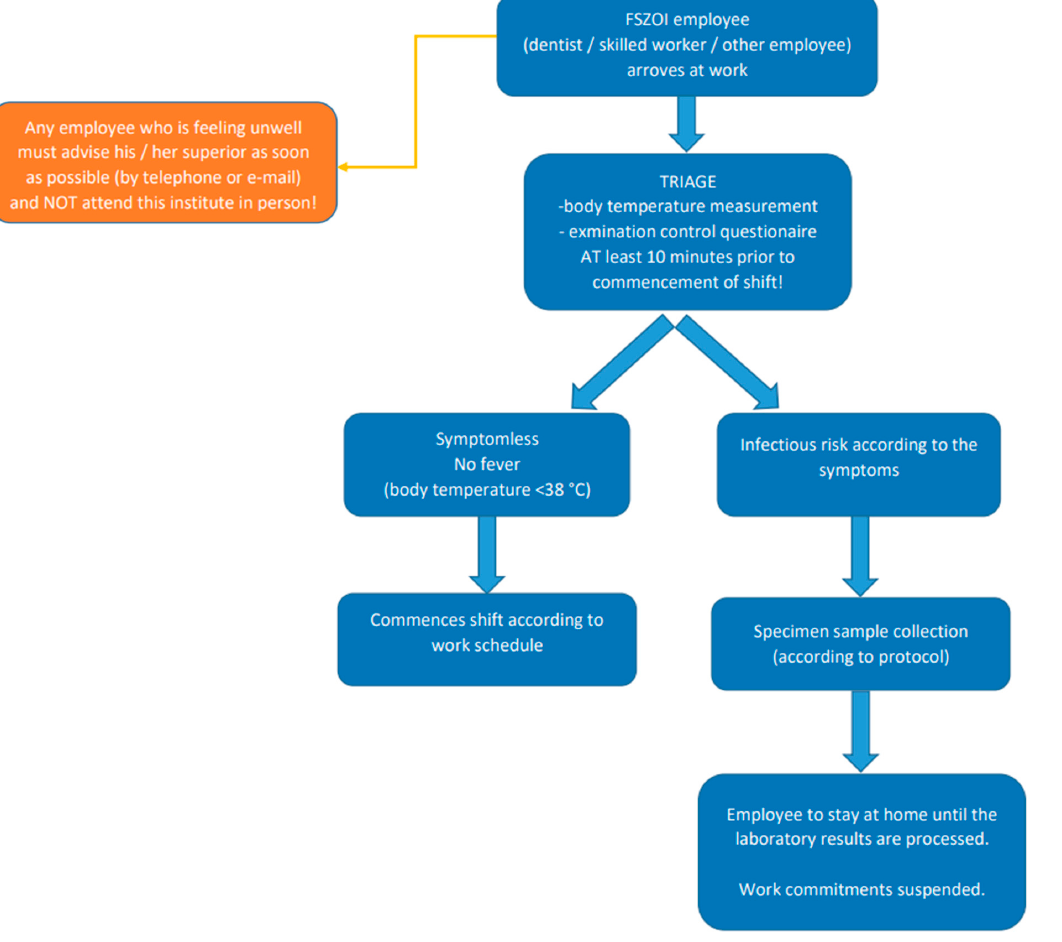
Figure 2. Employee screening in the Department of Community Dentistry of Semmelweis University (FSZOI).